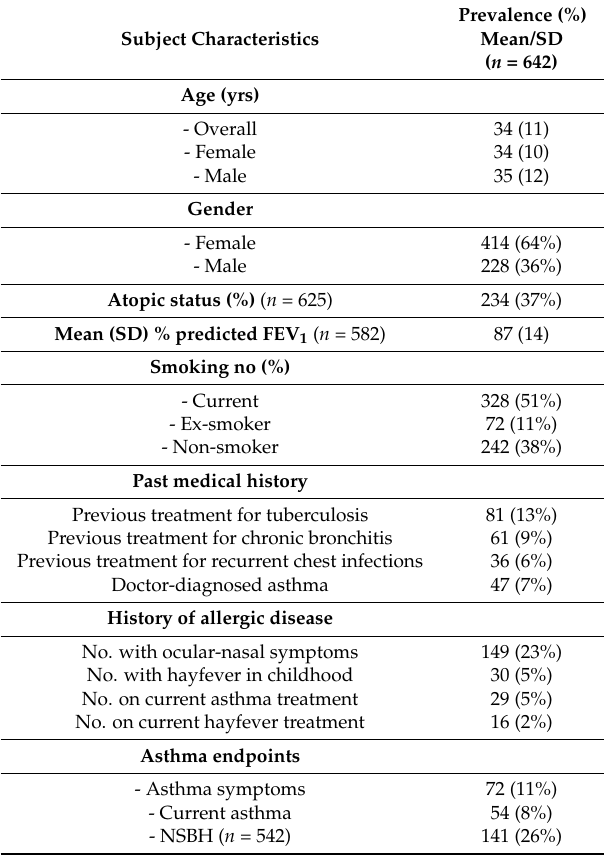
Table 1. Subject characteristics and asthma endpoints among fishing village inhabitants along the West Coast of South Africa.